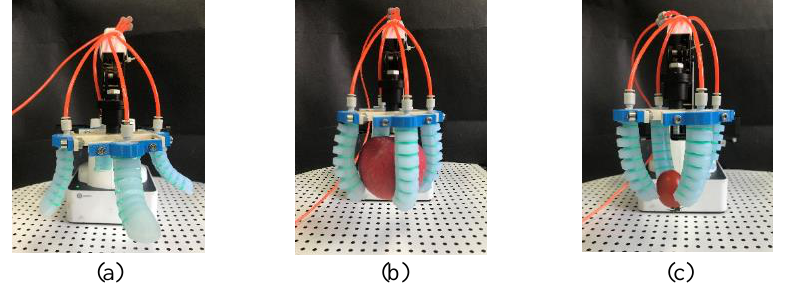
Figure 18. Soft manipulator grasping experiment. ( a ) Bending outward. ( b ) Enveloping grasping. ( c ) Fingertip grasping.